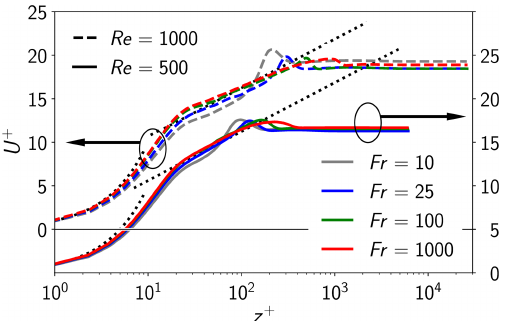
Figure 11. Velocity boundary layer after two inertial periods ( t − = 2) for various Fr and two Re showing the normalized ensemble- averaged geostrophic flow component U + . Baselines for cases with Re = 500 (solid lines) and Re = 1000 (broken lines) are offset by (cid:49)U + = 5 for better visibility. The empirical functions (dotted) are given for orientation and repeated from Fig. 4.